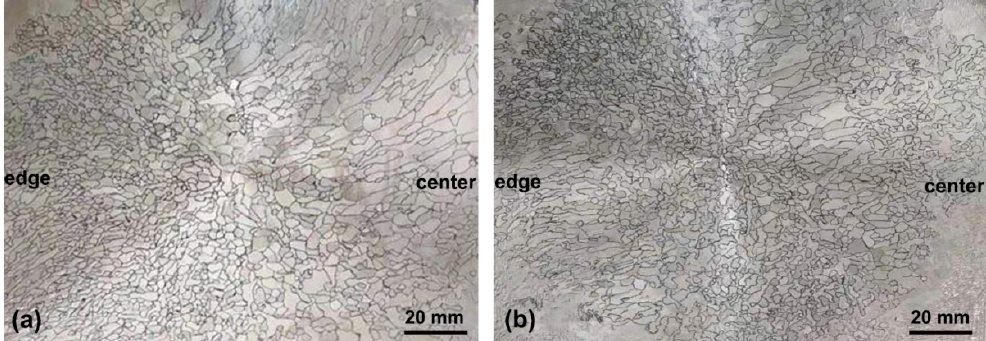
Figure 3. Grain morphology and distribution in the top slice of Air- ( a ) and He-cooled ( b ) ingots of NbTi alloy.